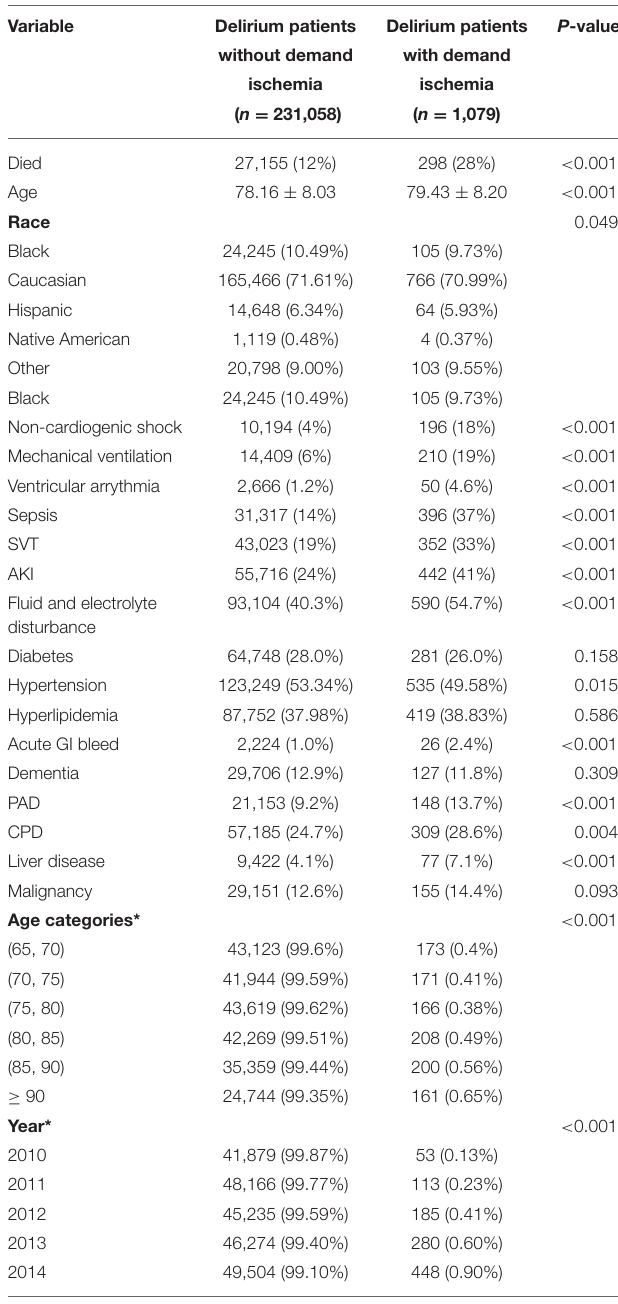
TABLE 1 | Baseline demographics and comorbidities of patients with and without demand